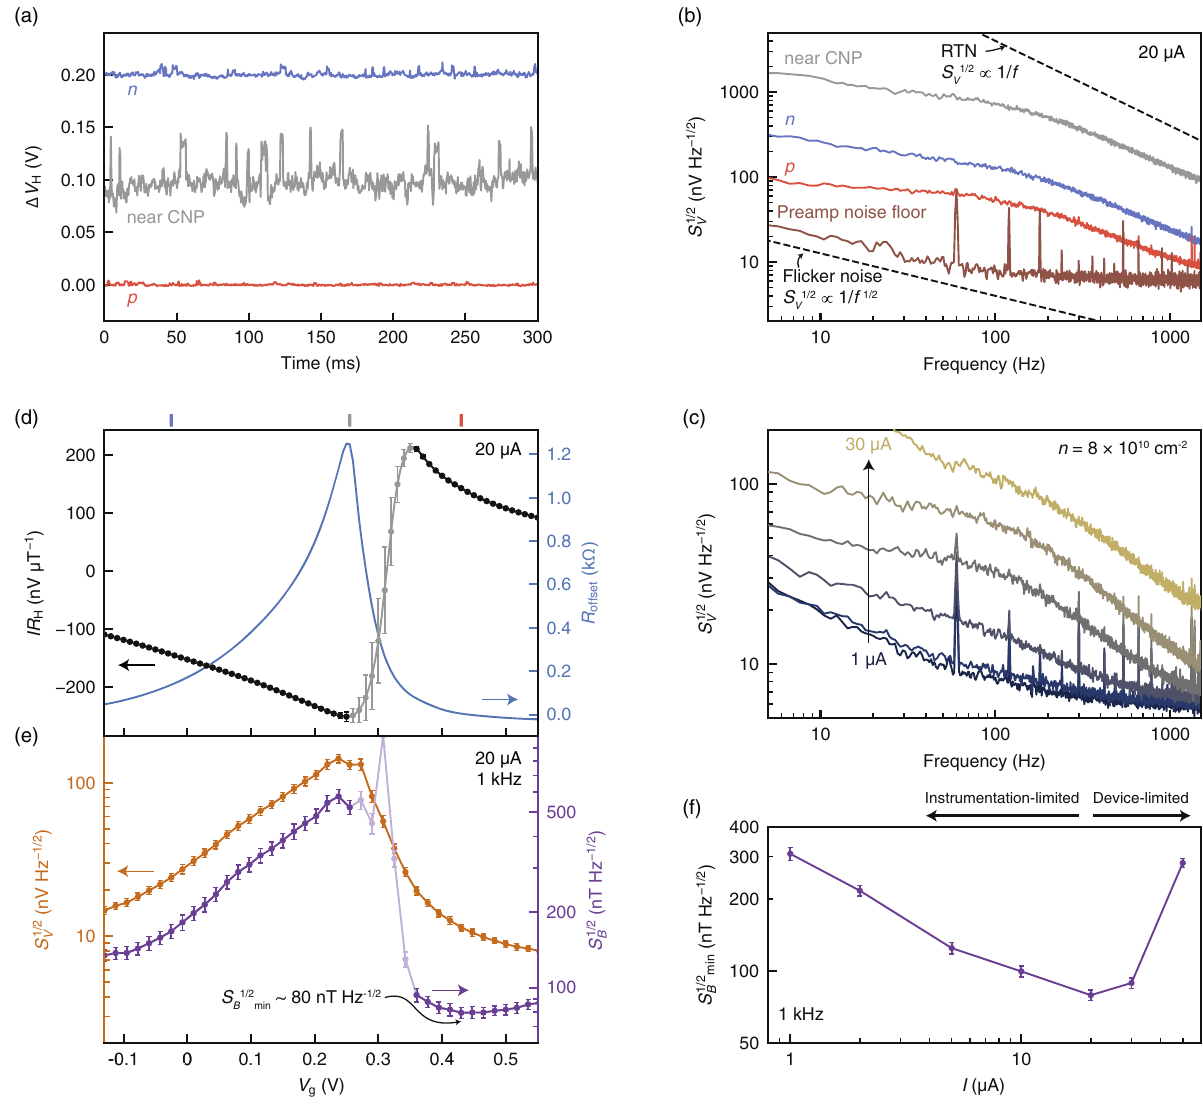
Fig. 4 Noise measurements. a Time traces of the Hall voltage (offset for clarity) and b Hall voltage noise spectral density S V 1/2 for device G1 at fi xed bias current and 4.2 K. The three curves correspond to the gate voltages marked at the top of the upper panel of ( d ). Dashed lines in b follow the expected dependence of random telegraph noise (RTN) at high frequency ( f − 1 ) and 1/ f noise ( f − 1/2 ). c Comparison of S V 1/2 spectra at different bias currents. At each bias current, we set V g such that R H ≈ 7.8 k Ω T − 1 , corresponding to n ≈ 8 × 10 10 cm − 2 . d IR H and R offset = V H ( B = 0)/ I for 20 μ A bias current. e S V 1/2 and magnetic fi eld detection limit S B 1/2 at 1 kHz. f Bias current dependence of the minimum S B 1/2 at 1 kHz. In panels d – f , error bars are determined considering the standard error of the linear fi t for R H and the standard deviation of S V 1/2 in a window of width 200 Hz centered at 1